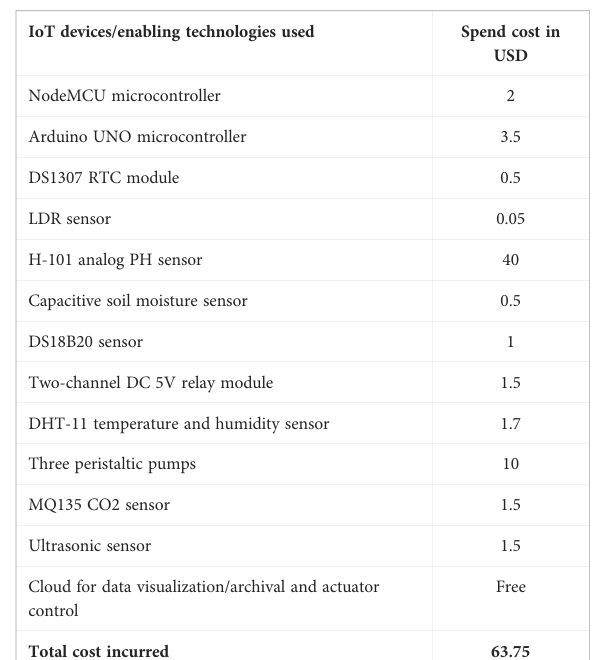
TABLE 3 Amount spent on IoT devices and enabling